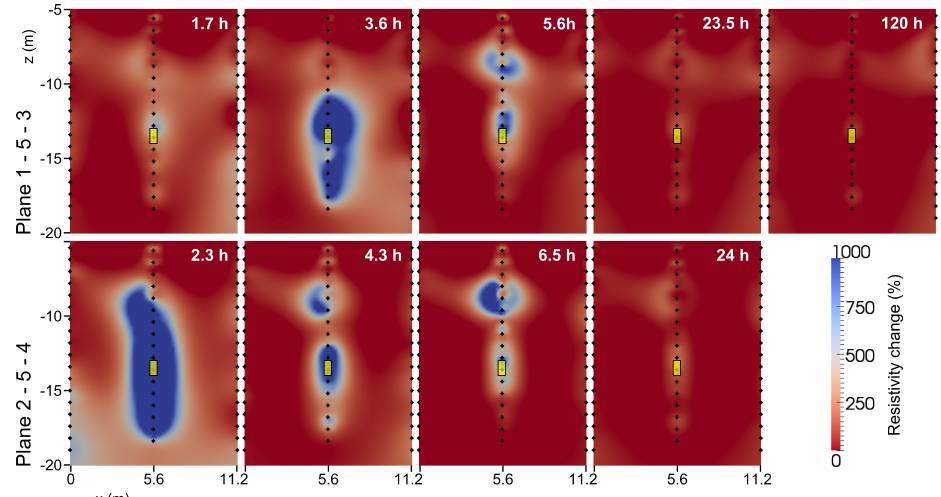
Figure 7. Electrical imaging (difference inversion) results for the field experiment at different times (in hours after start of injection). The top panel shows the results from borehole plane 1–5–3 and the bottom panel from plane 2–5–4. Black diamonds denote the position of